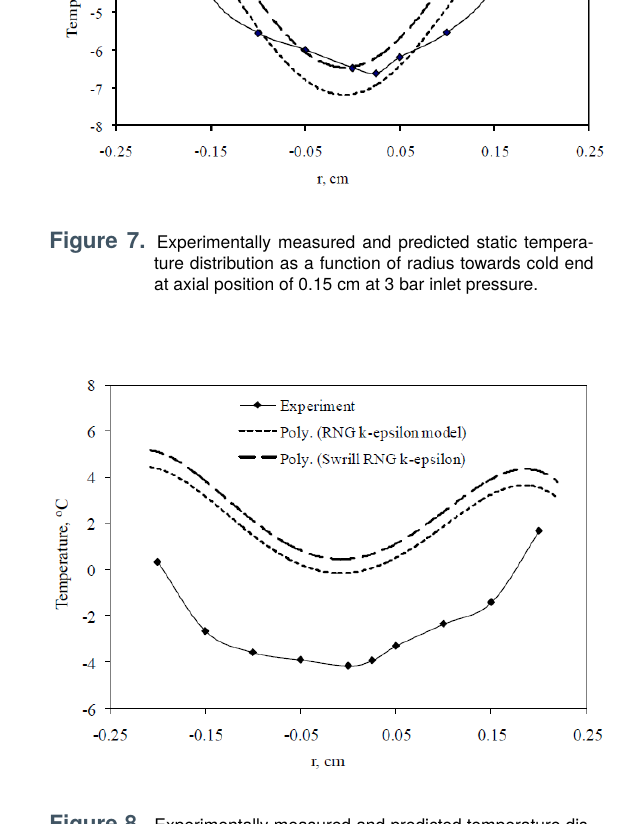
Figure 8. Experimentally measured and predicted temperature dis- tribution as a function of radius towards cold end at axial position of 0.3 cm at 3 bar inlet pressure.